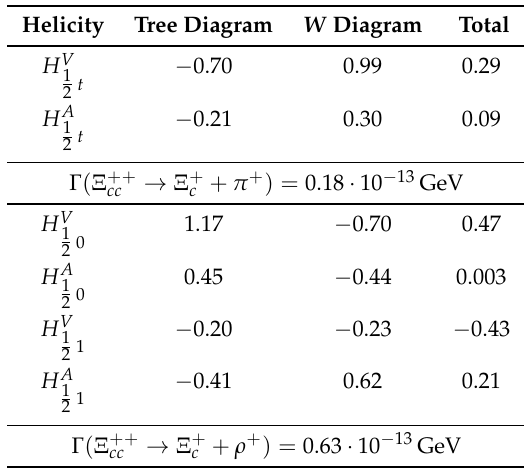
Table 7. Decays Ξ ++ cc → Ξ + c + π + ( ρ + ) .